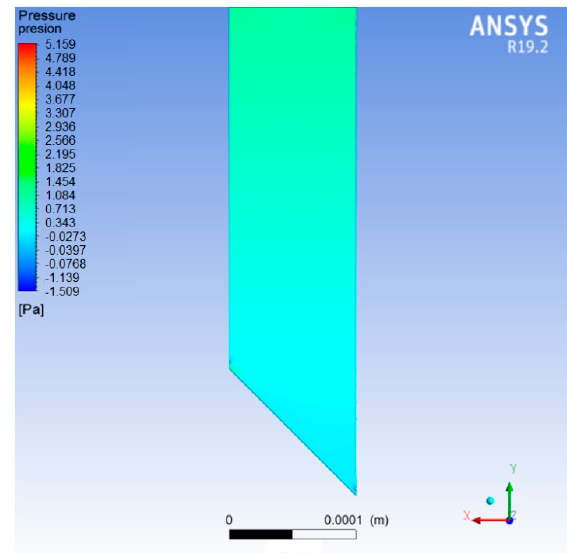
Figure 7. Contours of pressure for the microneedle.